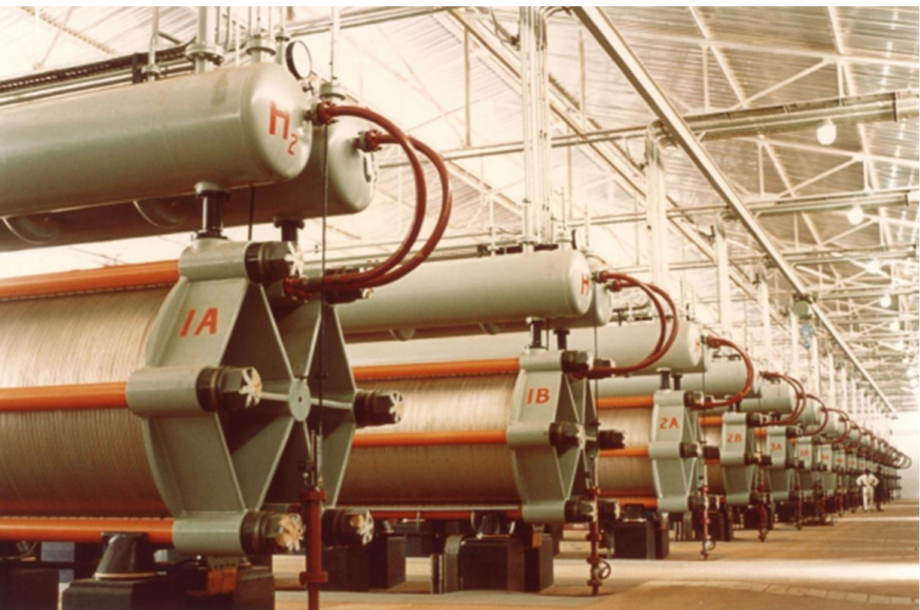
Figure 9. Top: Electrolyzers at the Cuzco ammonia production facility. Reproduced from refer- ence [43]. Bottom: Electrolyzers at the Kwekwe ammonia production facility. Reproduced from reference